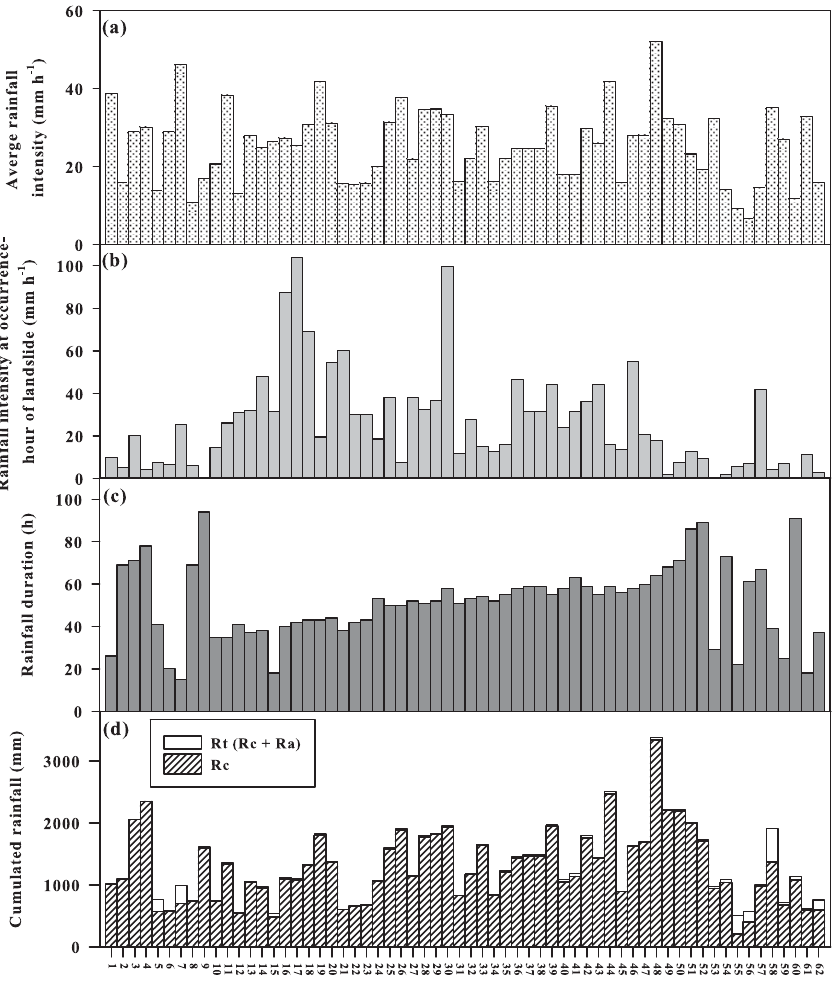
Figure 5. Single-factor rainfall analysis. Each large landslide is assigned an ID number in the figure. The ID numbers of large landslides are displayed in chronological order. ID 1–4 are the large landslides occurring in 2005; ID 5 is a large landslide occurring in 2006; ID 6–9 are the large landslides occurring in 2008; ID 10–52 are the large landslides occurring in 2009; ID 53 is a large landslide occurring in 2010; ID 54–56 are the large landslides occurring in 2011; ID 57–60 are the large landslides occurring in 2012; ID 61–62 are the large landslides occurring in 2013. No large landslides occurring in 2007 or 2014 were successfully paired with seismic signal results. Most large landslides occurred when rainfall duration exceeded 24h, cumulative rainfall exceeded 1000mm, and rainfall intensity was less than 20mmh − 1